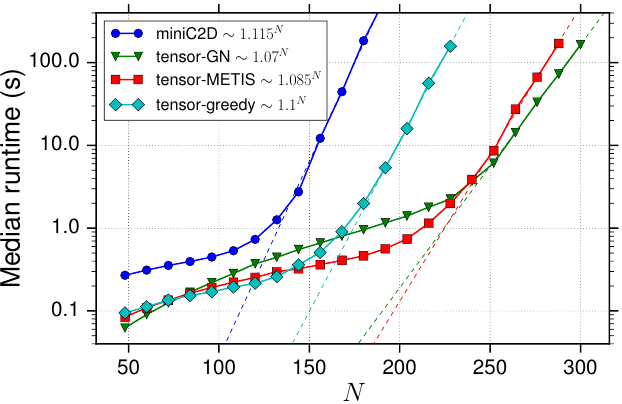
Figure 3: Median runtime scaling of tensor network contraction solvers and miniC2D for the solution of monotone #1- IN -3SAT on cubic graphs. All algorithms were run on the same random sample of 1000 instances of the problem. Dashed lines indicate the scaling extrapolated from the last 4 data points for each method. All calculations were performed on a single core of an AMD Opteron 6320 2800MHz processor with 64GB of RAM